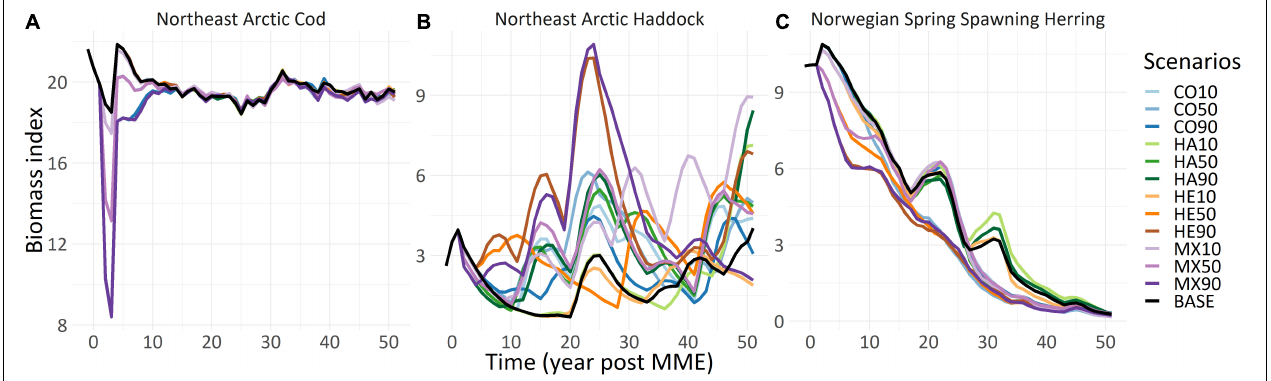
FIGURE 2 | Changes in total biomass index for (A) Northeast Arctic cod ( Gadus morhua ), (B) Northeast Arctic haddock ( Melanogrammus aeglefinus ), and (C) Norwegian spring spawning herring ( Clupea harengus) under twelve scenarios for reduced egg and larval survival (see Table 1 ) affecting one species at a time, or three species combined, compared to the baseline scenarios modeled using the NoBa Atlantis ecosystem model. Run “BASE” is the baseline, the same as the reduced survival scenarios up until year 0 of the simulation when the mortality event takes